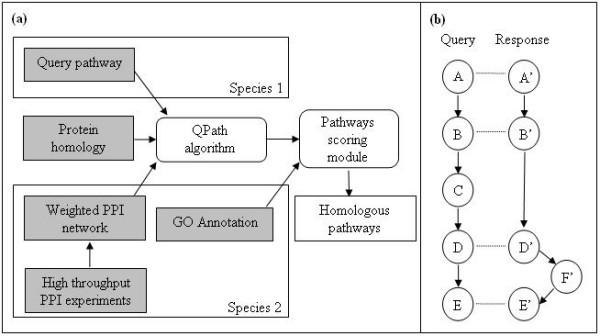
The QPath algorithmic flow. (a) Given a query pathway, a weighted PPI network, and sequence similarity scores between the query proteins and the network proteins, the QPath algorithm identifies a set of matching pathways. These are scored to capture the tendency of their constituent proteins to have a coherent function. (b) An example of an alignment that induces protein insertions (F') and deletions (C).